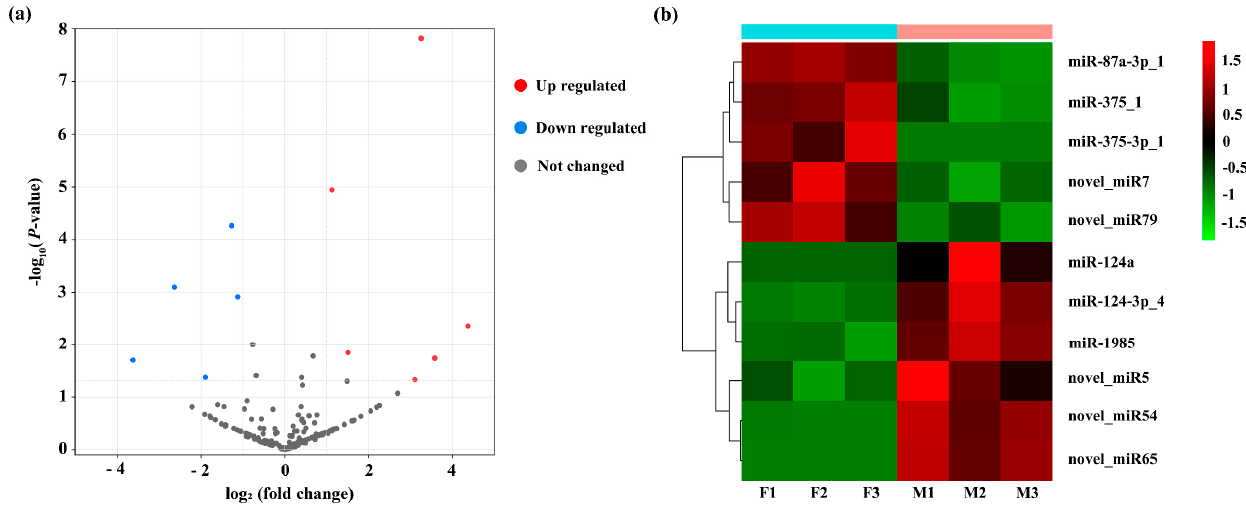
Figure 4. Expression profiles of miRNAs between ovary and testis of C. farreri . ( a ) The volcano plot exhibition of DEMs. X-axis, log2fold change of the miRNA expression levels between the testis and ovary. Y-axis, statistical significance of the miRNA expression. Red dots, upregulated miRNAs in the testis. Blue dots, upregulated miRNAs in the ovary. Grey dots, not significantly expressed miRNA between gonads. ( b ) The hierarchical clustering of miRNAs with the significant expression differences. Green or red on the heat map indicates a decrease or increase in miRNA expression levels, respectively.